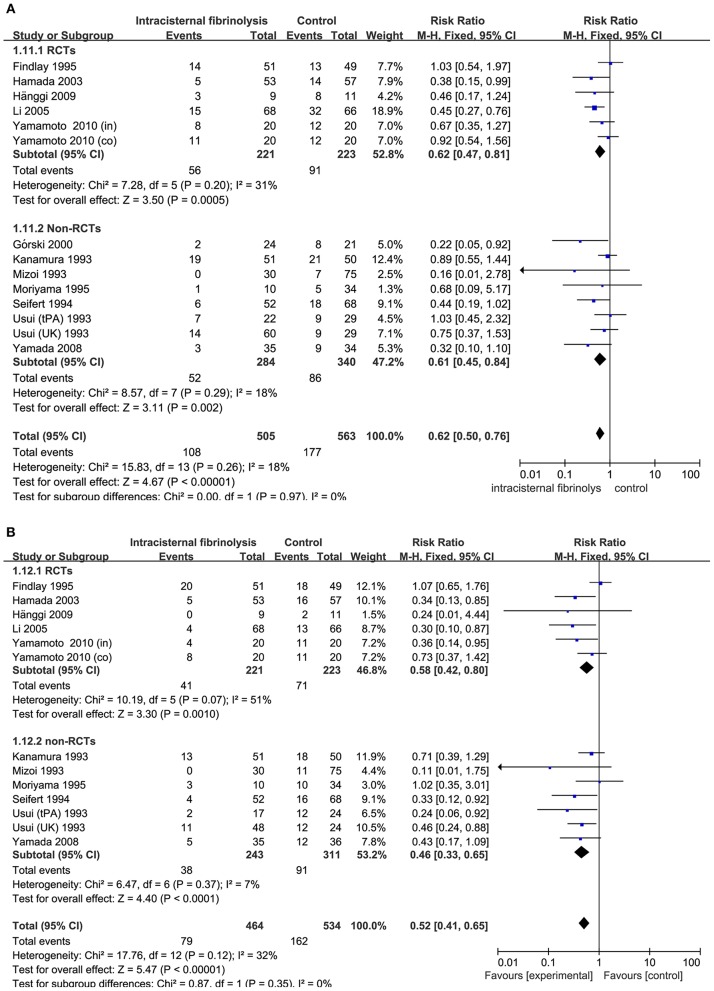
Meta-analysis of associations between intracisternal fibrinolysis and the risk of poor neurologic recovery (A) or the incidence of DIND (B) in patients with aSAH. aSAH, aneurysmal subarachnoid hemorrhage; CI, confidence interval; DIND, delayed ischemic neurologic deficit; M-H, Mantel-Haenszel method; RCTs, randomized controlled trials.